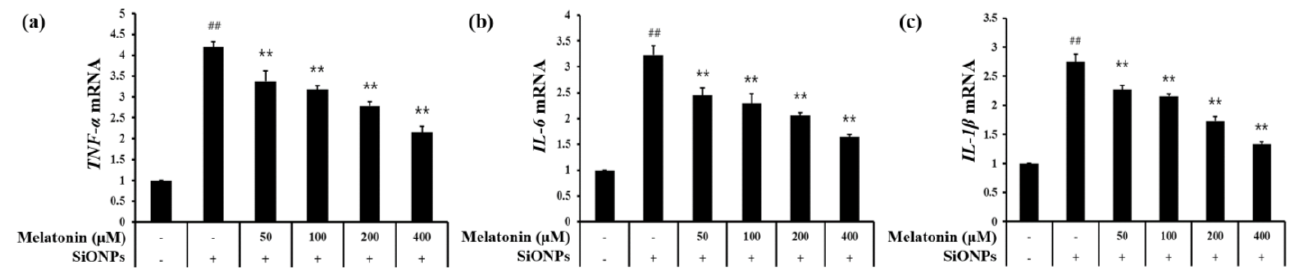
Figure 6. Melatonin suppressed the mRNA expression of inflammatory cytokines in SiONPs (12.5 µ g/mL)-stimulated cells as assessed using real-time PCR. ( a ) TNF- α ( b ) IL-6 , ( c ) IL- 1β ( n = 3). ## p < 0.01, vs. non-exposed cells; ** p < 0.01, vs. SiONPs-stimulated cells.